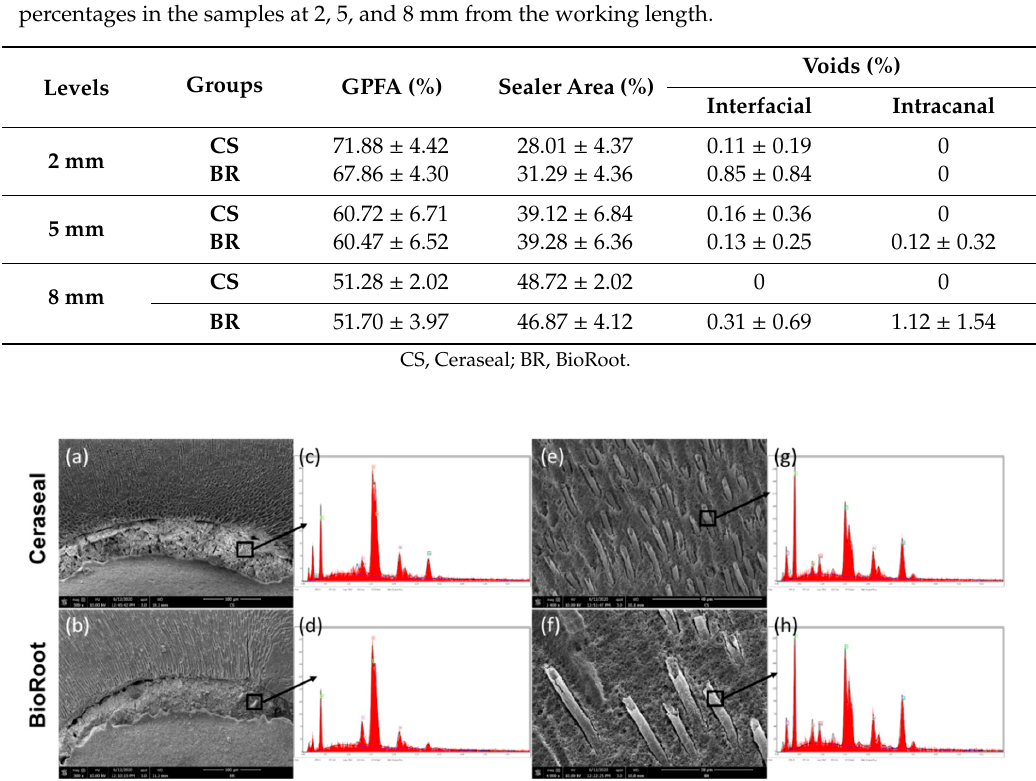
Figure 4. pH changes of water in contact with the sealer materials as a function of time for one week.